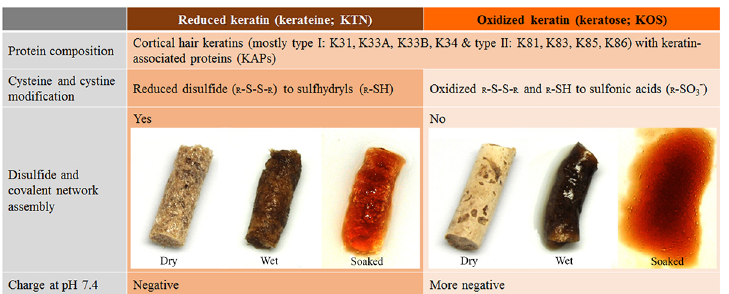
Fig 1. Comparison between reduced (KTN) and oxidized (KOS) keratin biomaterials. KTN can form disulfide linkages to produce a stable scaffold; but KOS cannot, due to the sulfonic acid modification of thiol groups. Consequently, the electrostatic properties are also altered, resulting in more negatively-charged KOS scaffolds, prone to more rapid hydrolytic degradation than KTN scaffolds. 10 mM NaOH solvent was used for wetting and